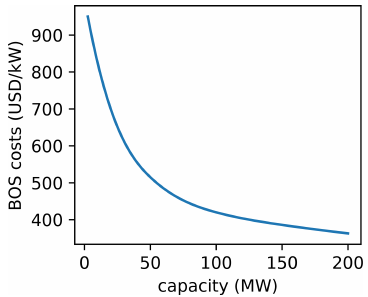
Figure 3. The balance of station (BOS) cost model (per kilowatt of installed wind power plant capacity) as a function of the total power plant capacity (Key et al., 2020).